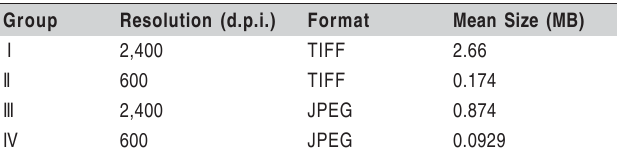
Table 1. Digitized image groups according to file resolution, format and mean size.